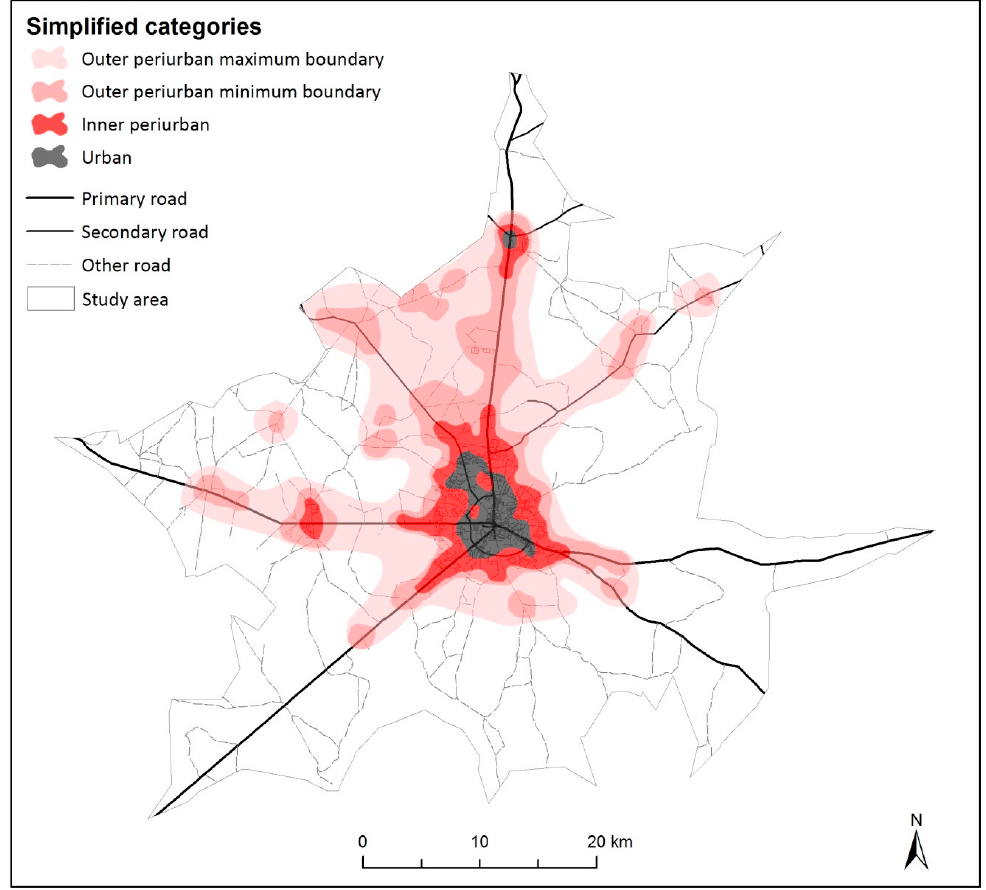
Figure 14. Simplified boundaries showing urban, periurban and rural boundaries.